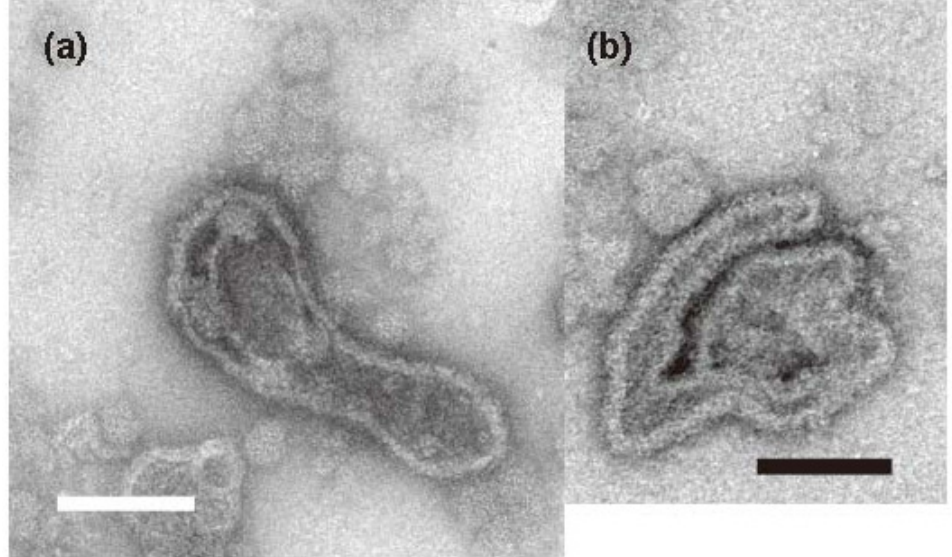
Figure 4. Typical images of crookedly elongated SR vesicles. SR vesicles were incubated at 0.002 ( a ) and 0.026 ( b ) µM Ca 2+ in the absence of ATP for 1 min. Scale bar: 100 nm.